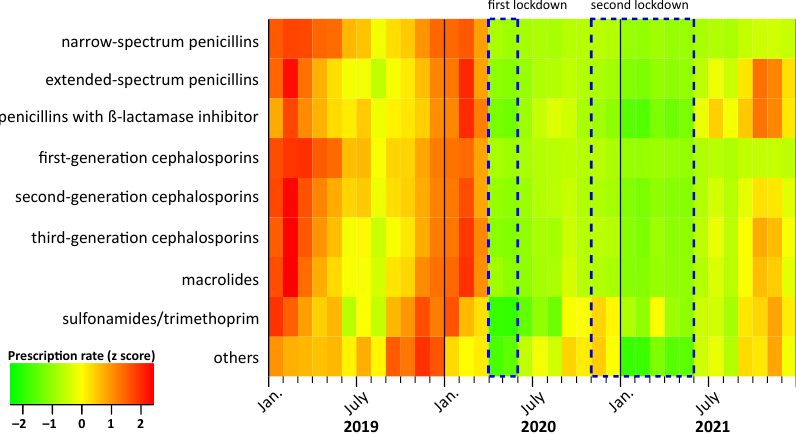
Figure 2. Trends in monthly antibiotic prescription rates per 1000 children aged between 0 and 14 years by antibiotic subgroup in the period 2019 to 2021. Original data can be found in Table S3. Values for prescription rates (x) were converted into z-scores using the formula : x(cid:2)z − score(cid:10) = (cid:12)(cid:13)(cid:14)(cid:15)(cid:16)(cid:17)(cid:2)(cid:12)(cid:10) to obtain mean = 0 and standard deviation (SD) = 1.